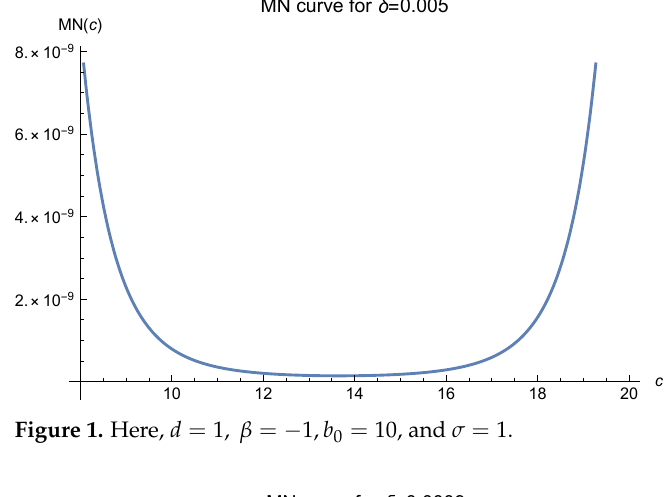
Figure 1. Here, d = 1, β = − 1, b 0 = 10, and σ = 1.